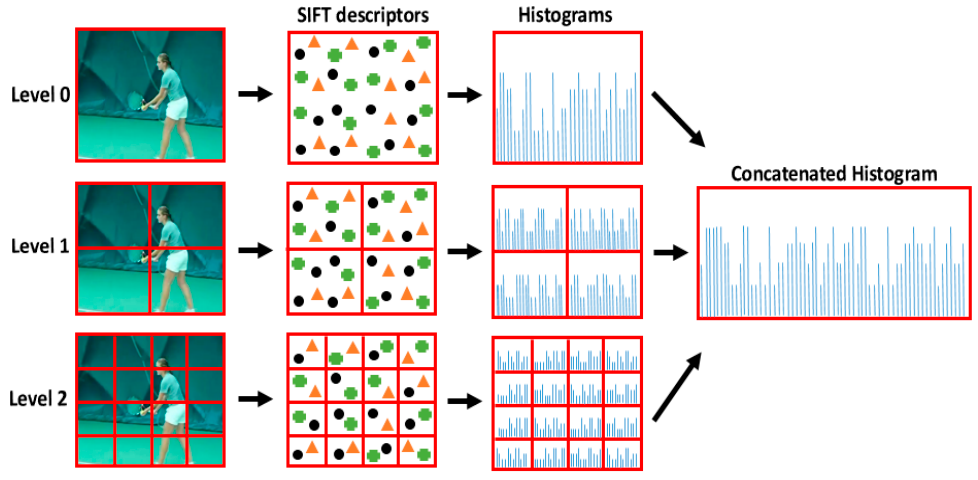
Figure 9. SPM feature